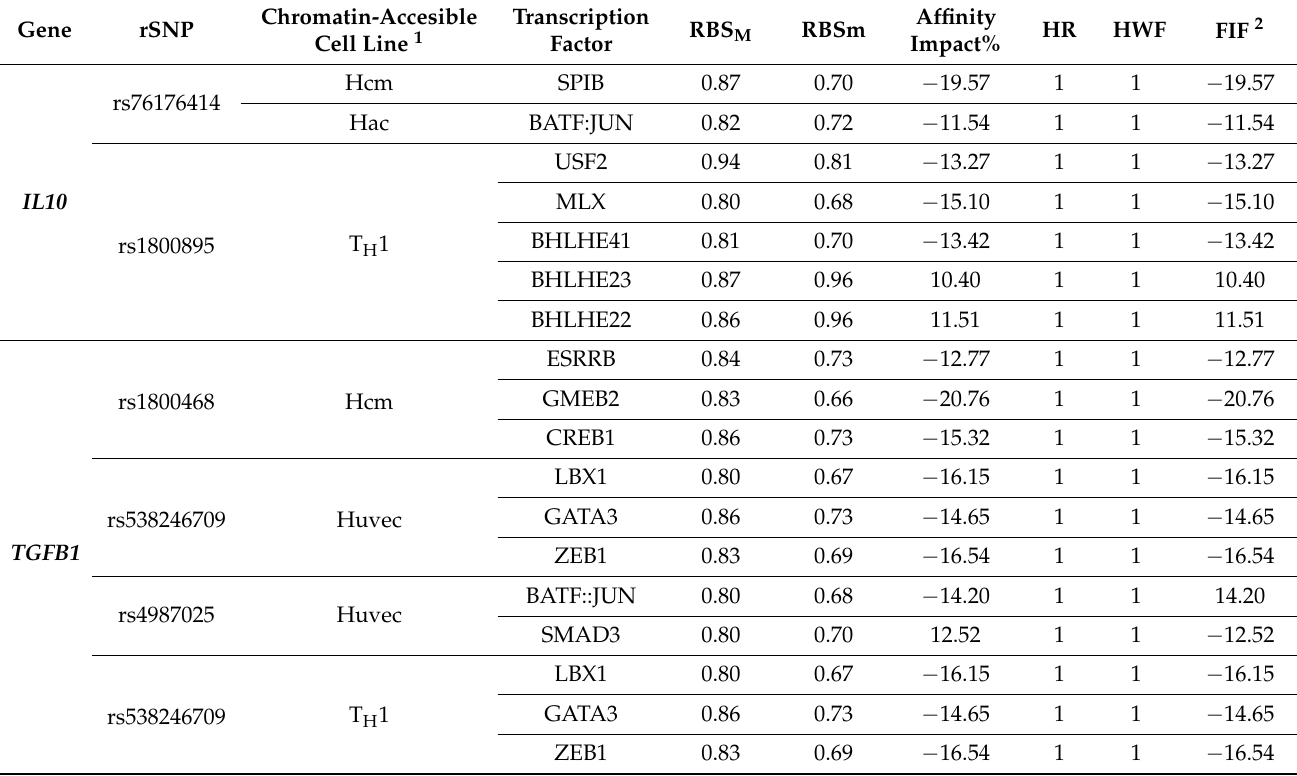
Table 2. Prediction of rSNPs with SNPClinic v.1.0 software. SNPClinic outputs include cell line specificity, altered TFBS and quantitative ranking according to transcriptional relevance with the Functional Impact Factor